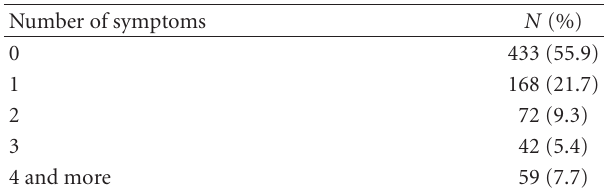
Table 3: Percentage of highly rated insomnia symptoms among